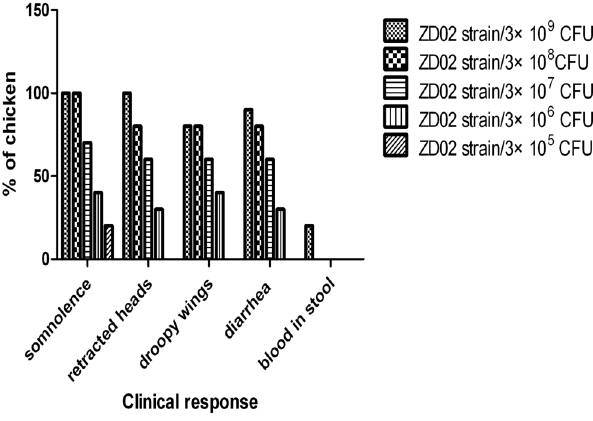
Figure 2. Clinical responses of chickens after intraperitoneal injection. Each bar denotes number of the clinical response/total in each experimental group after 12 h of intraperitoneal injection with Shigella strain